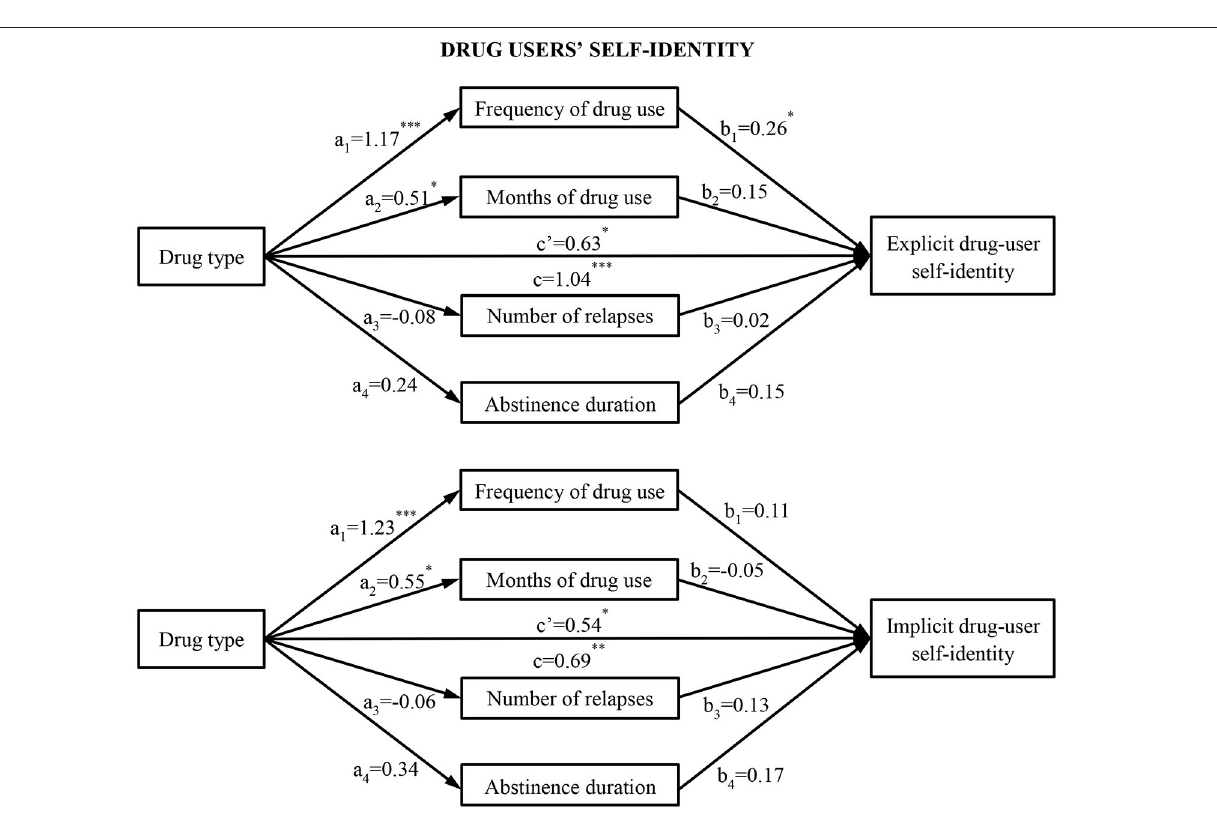
substances, despite having abstained from drug use for a period of